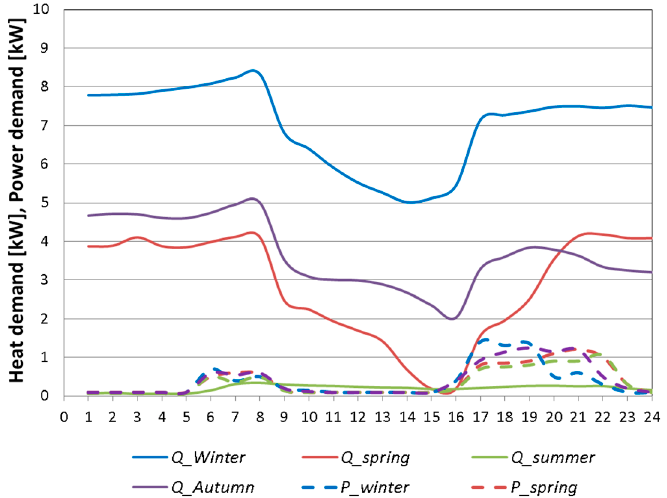
Figure 5. Total heat demand (solid line) for space heating and DHW within one day in different seasons and the assumed power demand profile (dashed line).